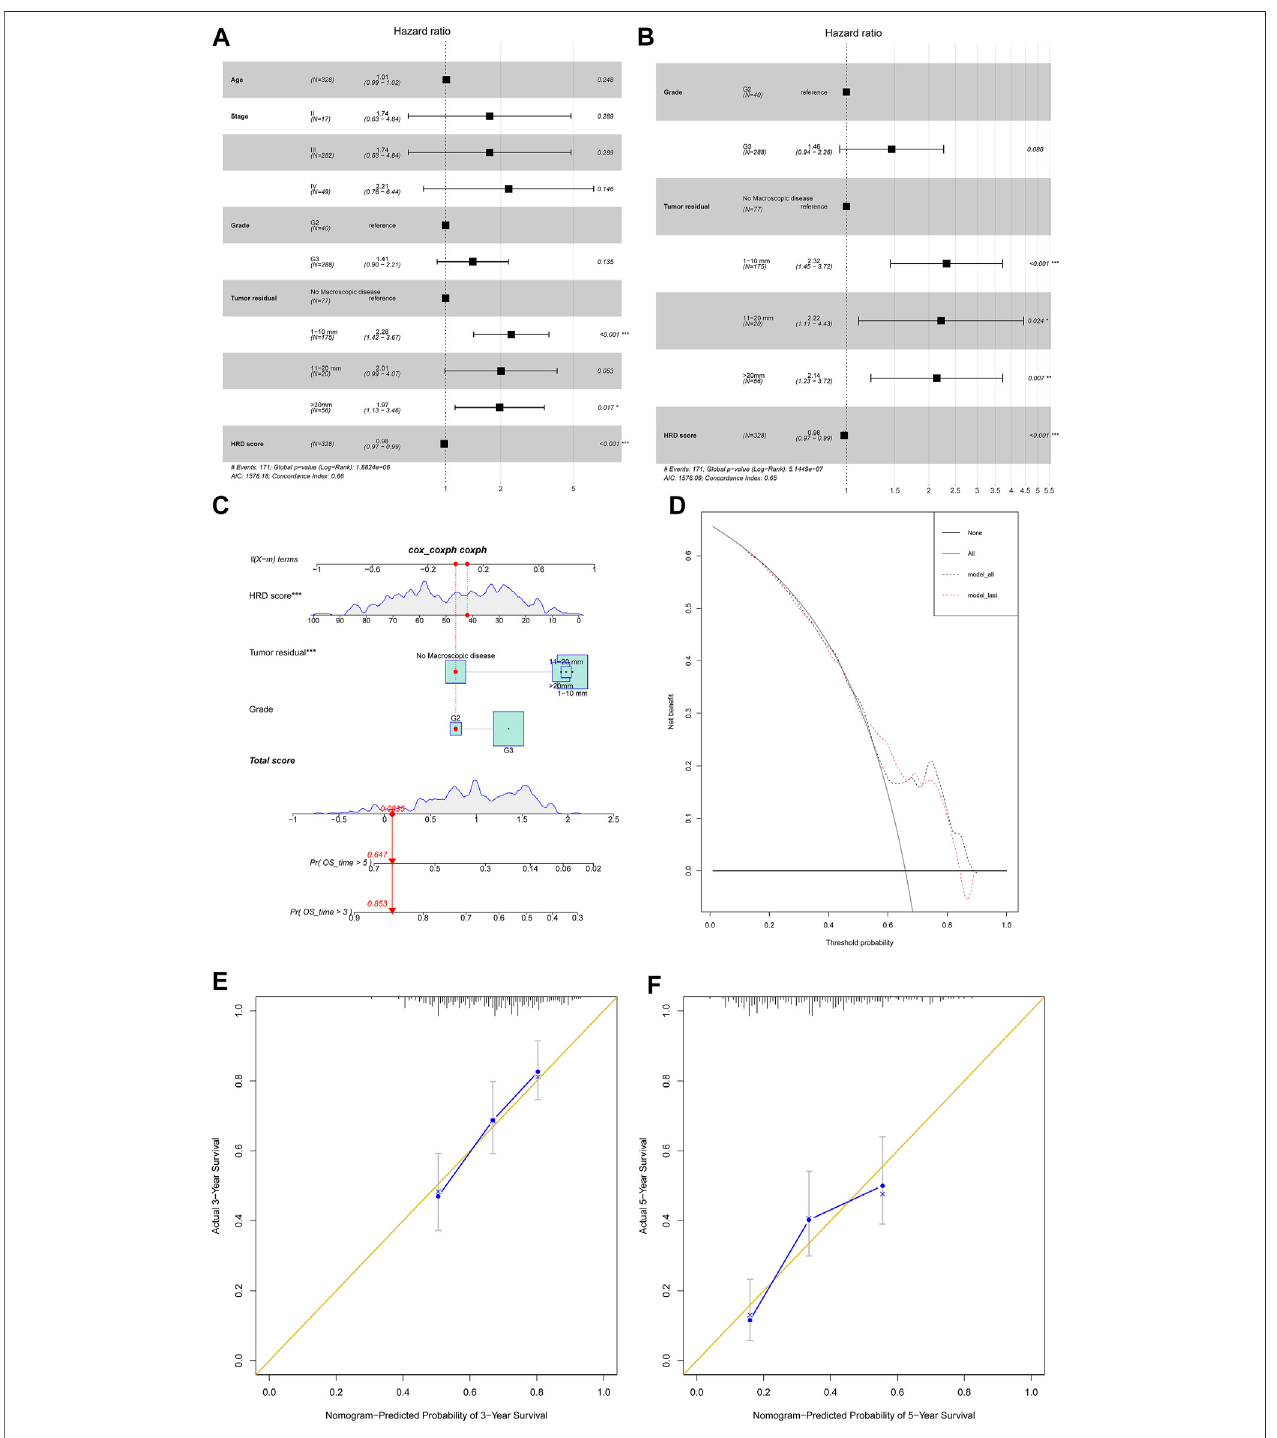
FIGURE 5 | (A) Forest plot displayed the association of clinical characteristics with OS by the COX regression analysis, including factors like patient age, tumor stage, tumor grade, tumor residual, and HRD score. (B) Forest plot displayed the COX regression analysis for OS with stepwise bidirectional elimination selection. (C) Nomogram to predict the 3- and 5-year survival. Pr: probability. (D,E) Calibration curve for 3- and 5-year OS nomogram models. The gold line represents the ideal nomogram, and the blue line represents the observed nomogram. (F) Decision curve analysis. Net bene fi t curves for model with three characteristics compared with model with all characteristics. y -axis measures net bene fi t which is calculated by summing the bene fi ts (true positives) and subtracting the harms (false positives).